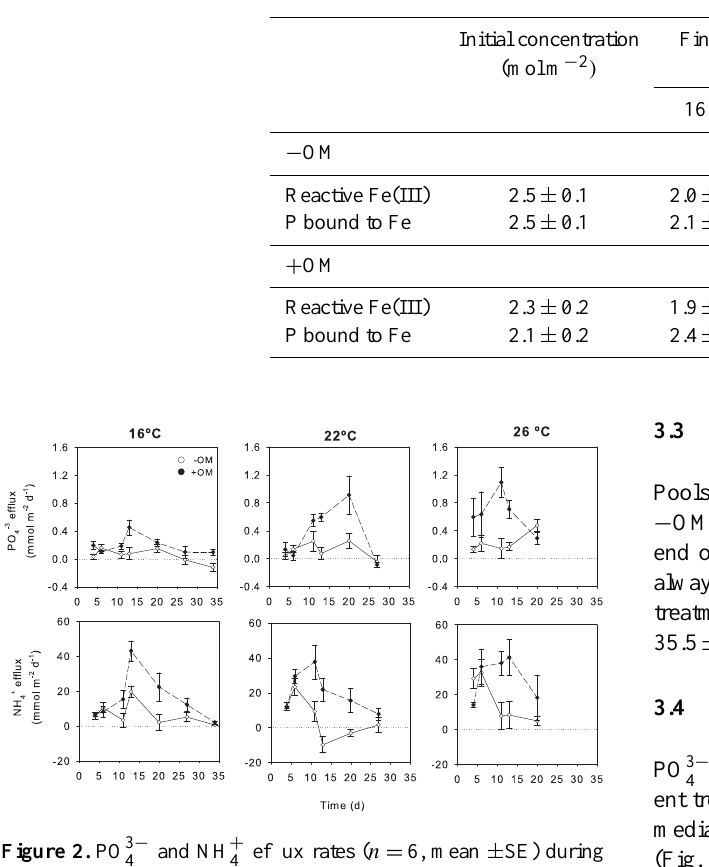
Figure 2. PO 3 − and NH + efflux rates ( n = 6, mean ± SE) during 4 4 the experiment at the three temperature scenarios under nonorganic ( − OM) and organic enrichment ( + OM) conditions. Dotted lines are the line of reference corresponding to